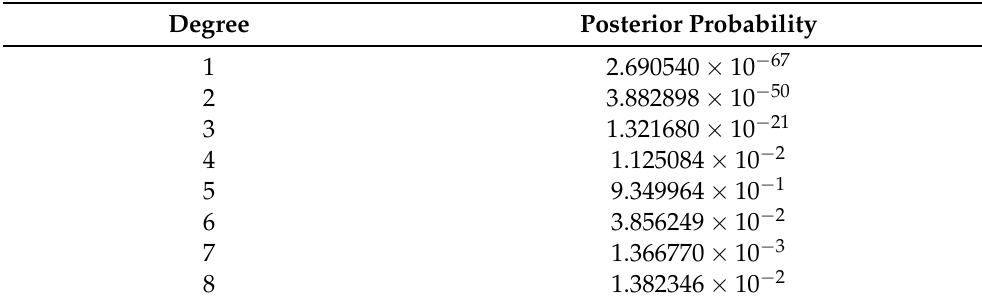
Table 3. Study of infected: Posterior probabilities of the polynomial regression model of degree less than or equal to 8 for the multi-sigmoidal Weibull